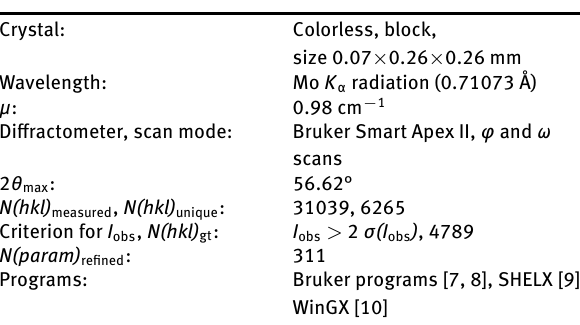
Tables 1–3 contain details of the measurement method and a list of the atoms including atomic coordinates and displace- ment parameters. Table 1: Data collection and handling.